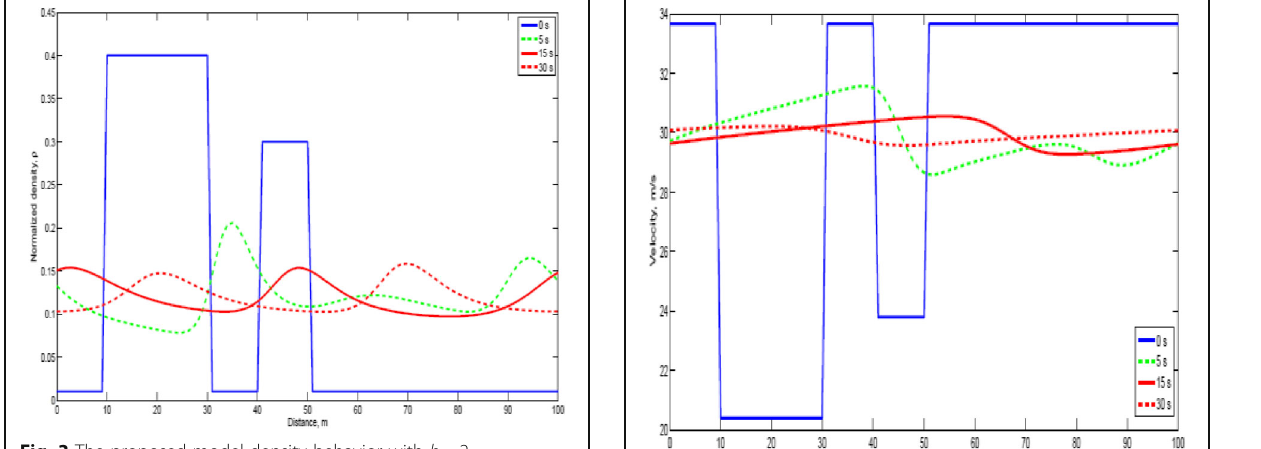
Fig. 3 The proposed model density behavior with b = 2